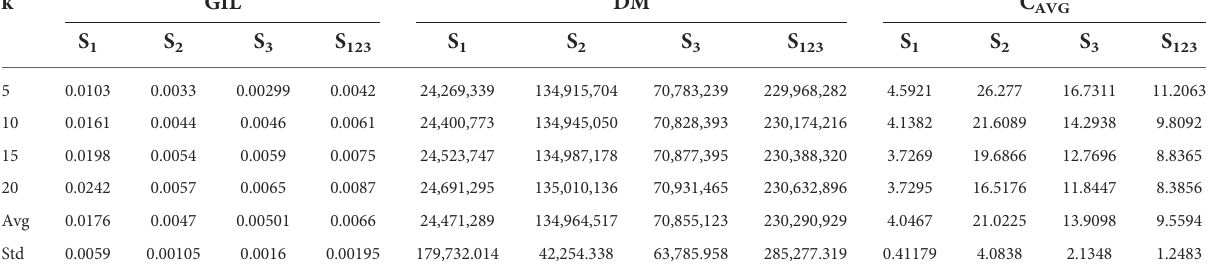
TABLE 2 Results of the generalized information loss (GIL), discernibility metric (DM) and average equivalence class size (C AVG ) on data sets S 1 , S 2 , S 3 , S 123 for the chosen k values. The average values (Avg) and the standard deviation (Std) of the results have been also